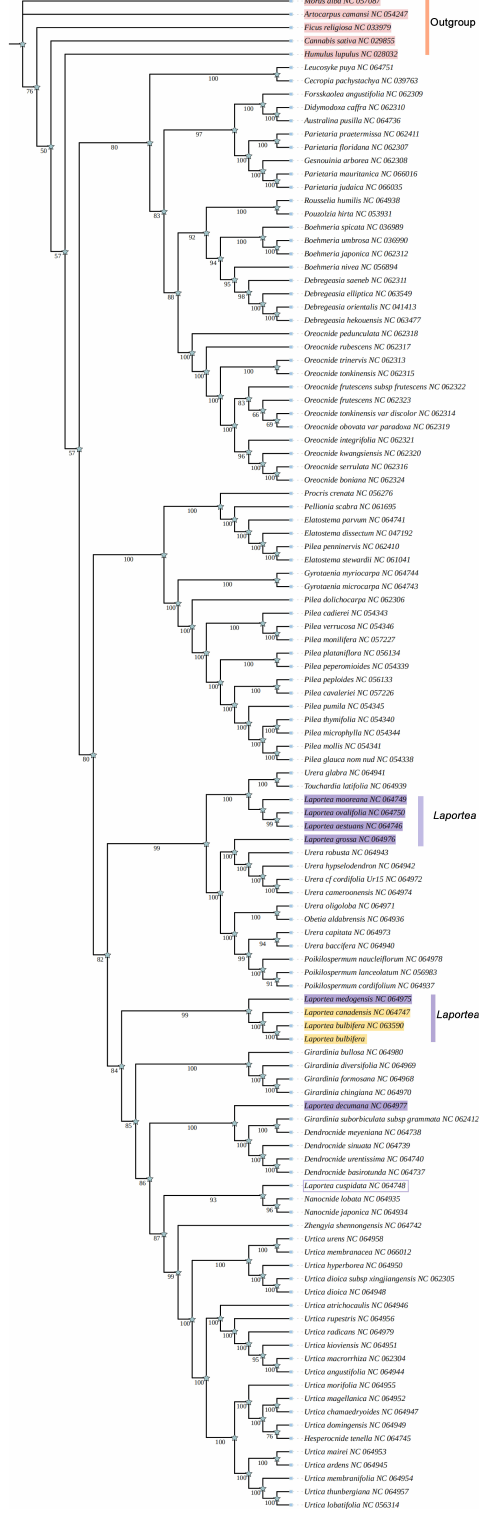
Figure 6. The phylogenetic tree of species from Urticaceae is based on the 115 CDSs from 114 taxa using the maximum likelihood (ML) method. The purple markers are species of the genus Laportea . The yellow section shows that both the data from the previous study and the resequencing data in the present study indicate that L. bulbifera and L. canadensis are most closely related. The purple part indicates species of the genus Laportea , L. decumana clustered as a single clade, L. cuspidata clustered as a clade with species of the genus Nanocnide